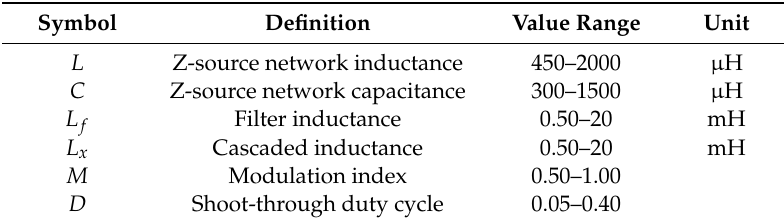
Table 1. LVC-qZSI circuit